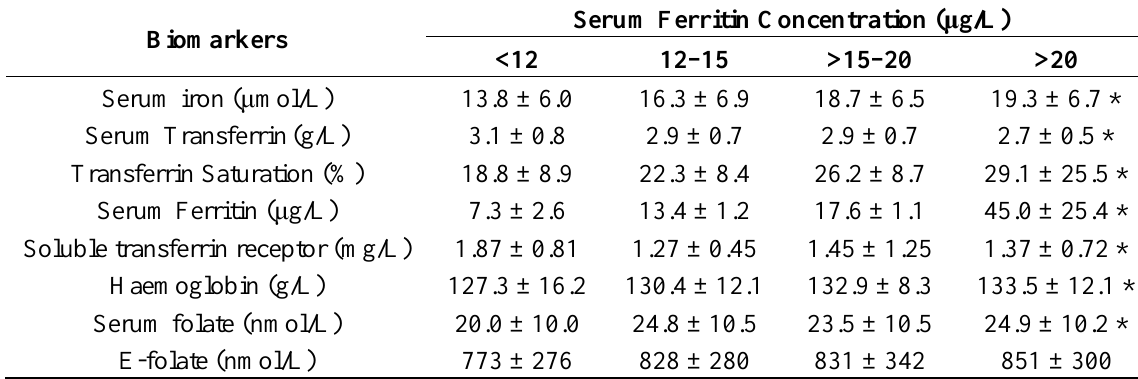
Table 2. Concentrations of iron and folate biomarkers stratified by serum ferritin concentrations 1 .